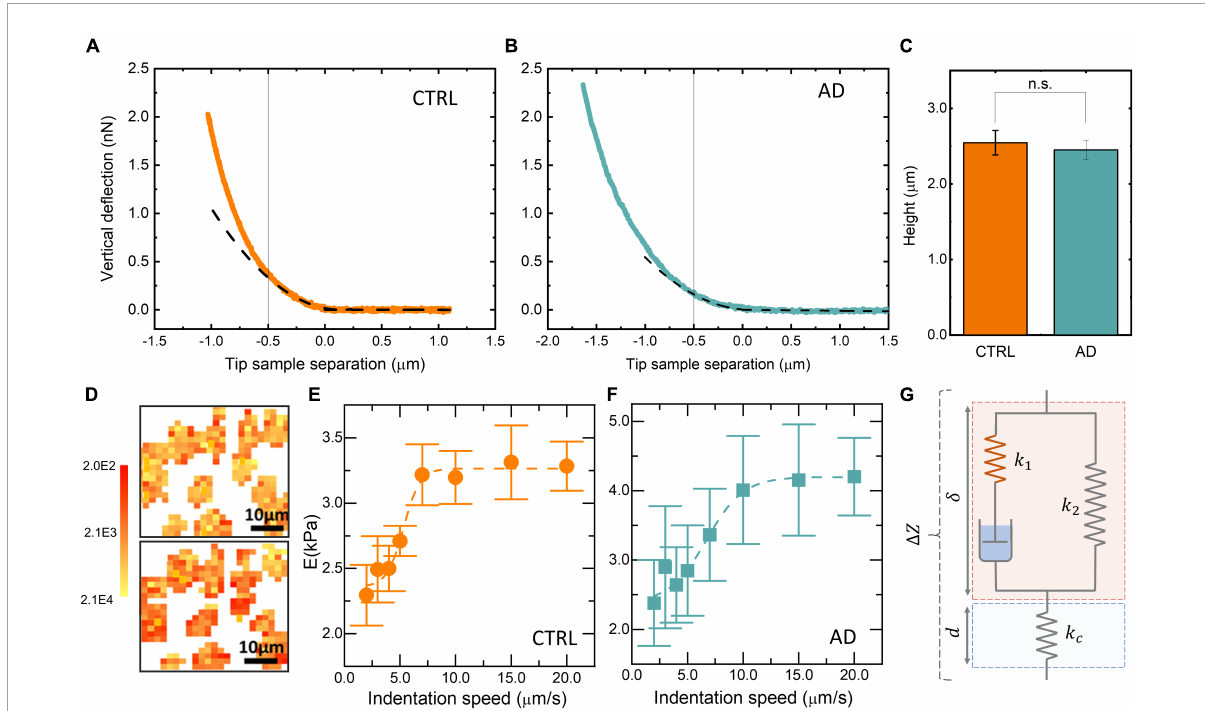
FIGURE1 Representative force–distance (FD) approach curve acquired on a red blood cell (RBC) obtained from a control subject (A) and an Alzheimer’s disease (AD) patient (B) . Average RBC height in liquid environment (C) . Two representative RBC maps acquired at 20 µ m/s ( D , upper panel) and 5 µ m/s ( D , lower panel). Average Young’s modulus E as a function of the indentation speed for a control subject (E) and a patient with AD (F) . Schematic view of the standard linear solid (SLS) model (G)